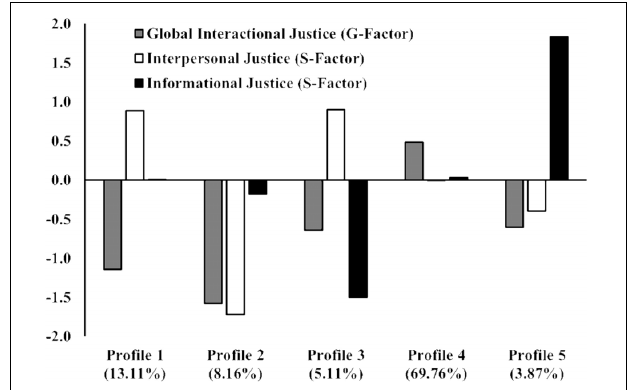
FIGURE 1 | Final five-profile solution (bifactor CFA factor scores). Profile 1: high interpersonal/average informational; Profile 2: low interpersonal; Profile